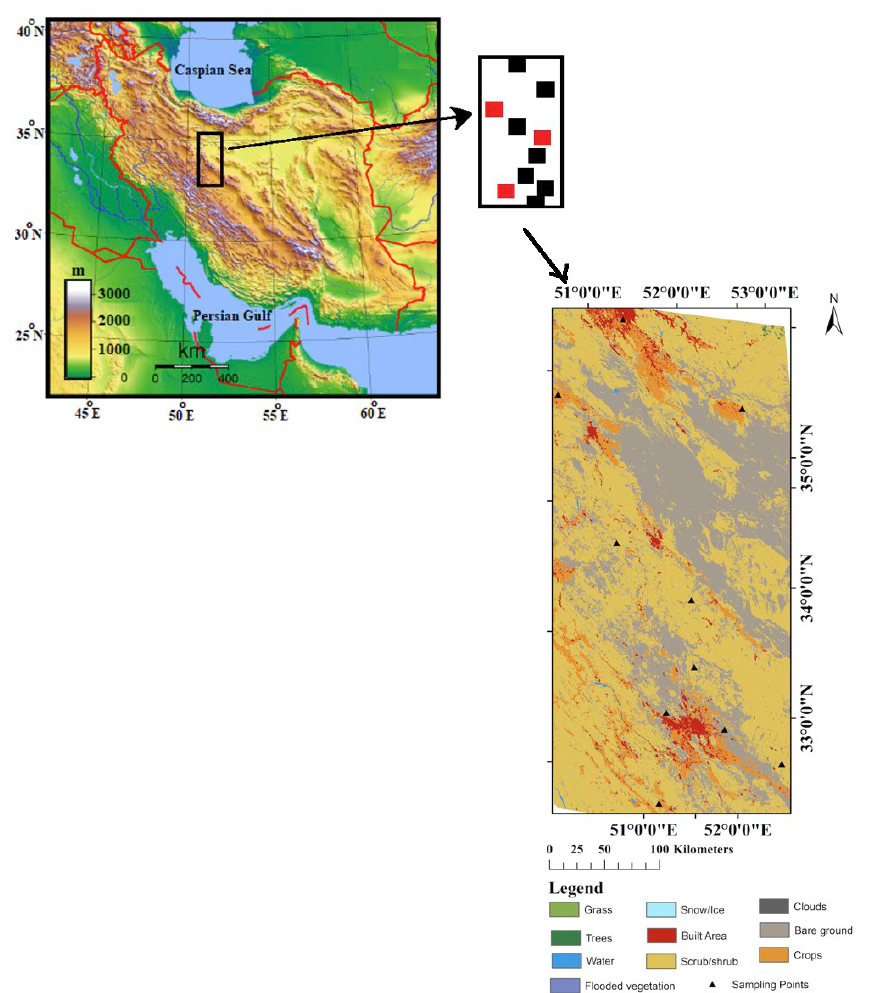
Figure 1. Spatial distribution of the ground stations (Solid black and red squares are locations of calibration and check stations, respectively) and geographic location (Rectangular polygon) of the study region along with the land cover.